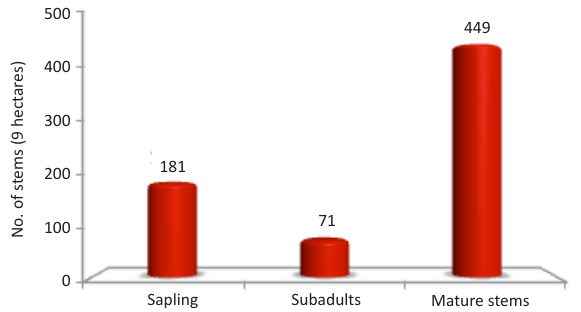
Figure 2. Population Structure of E. venustus in Kanyakumari